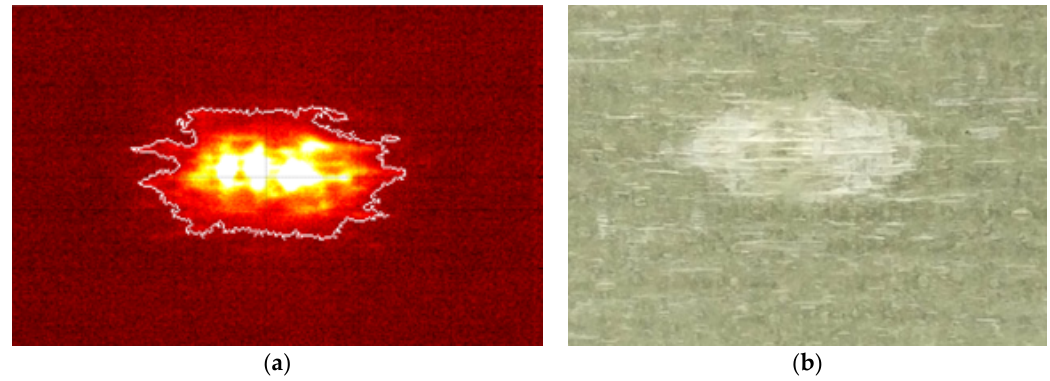
Figure 5. Comparison between contoured image ( a ) and photo of the rear to impact specimen surface ( b ) for E = 8.3 J. ( b ) for E = 8.3